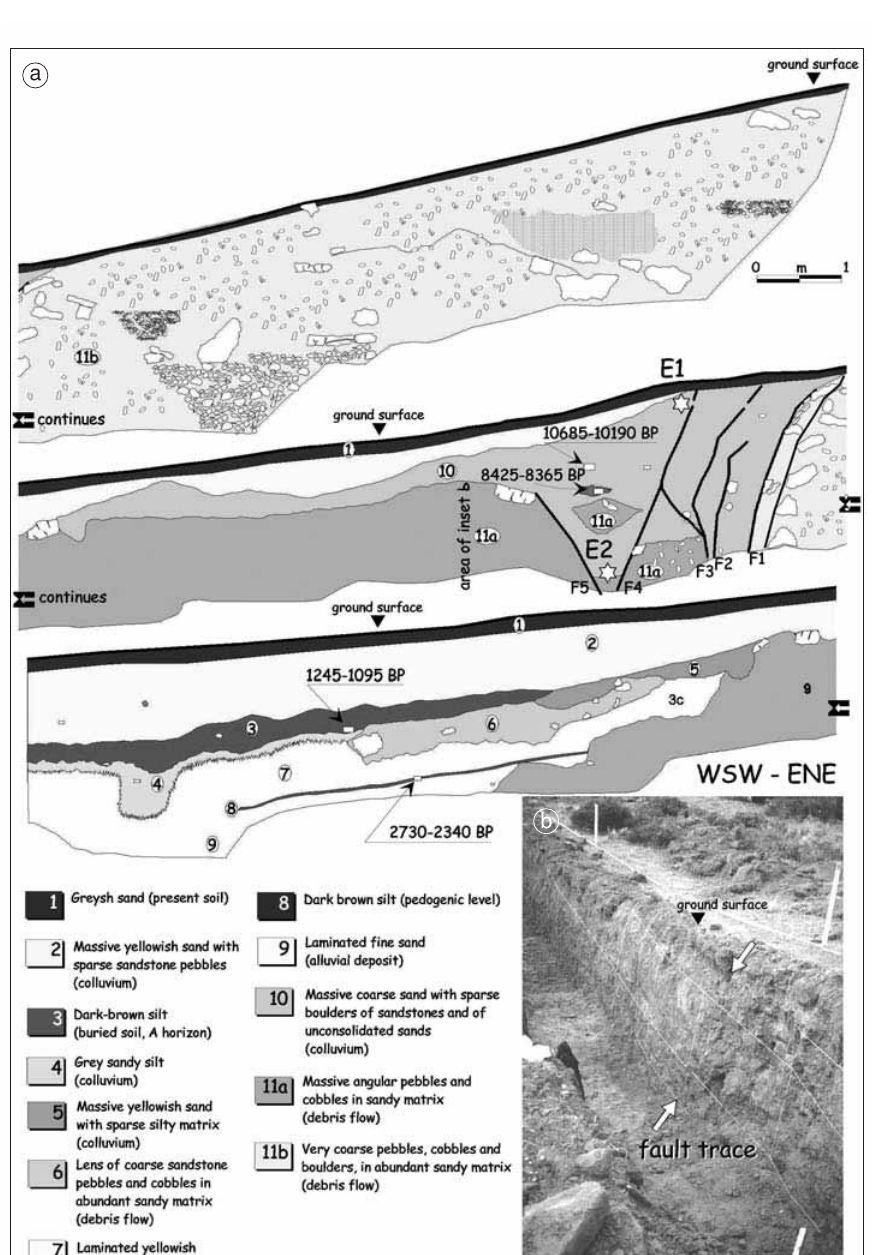
Fig. 10a,b. a) Log of the NW wall of the trench excavated across the Laga Mts. Fault at site 3 in fig. 9d; the paleoseismological analysis defined the occurrence of two displacement events after 8425-8365 years BP. b) Panoramic view of the investigated trench